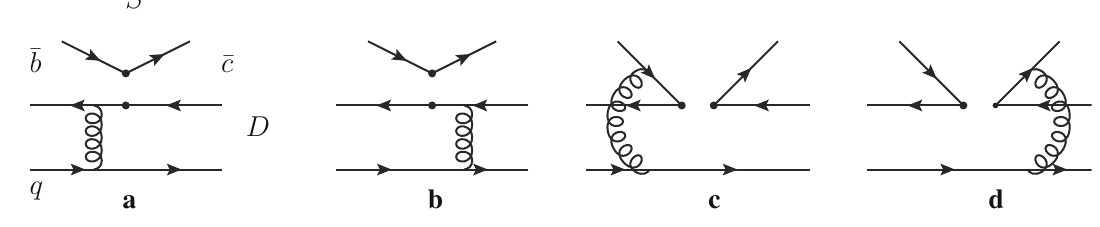
( ∗ ) S decays with a scalar meson emitted in PQCD